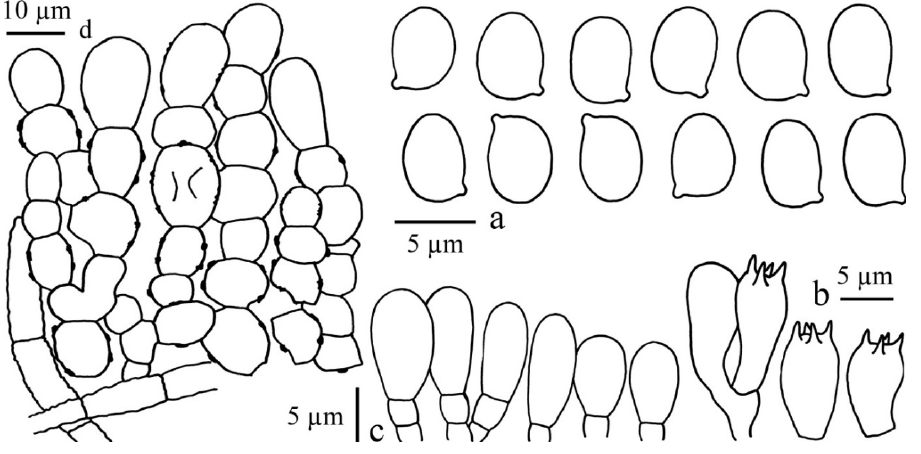
Figure 26. Microcharacters of Xanthagaricus necopinatus (MFLU 19-2353). ( a ) basidiospores. ( b ) basidia. ( c ) cheilocystidia. ( d ) pileus covering.